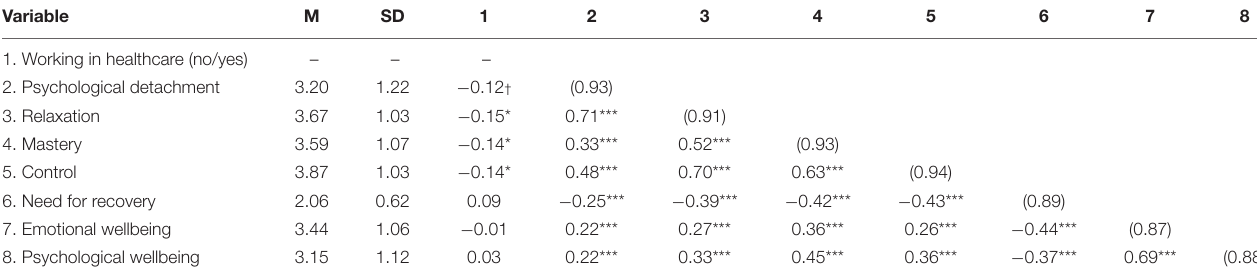
TABLE 1 | Descriptive statistics (means and SDs), r Bravais-Pearson’s correlations, and McDonald’s ω reliability coefficients ( N = 217). Variable M